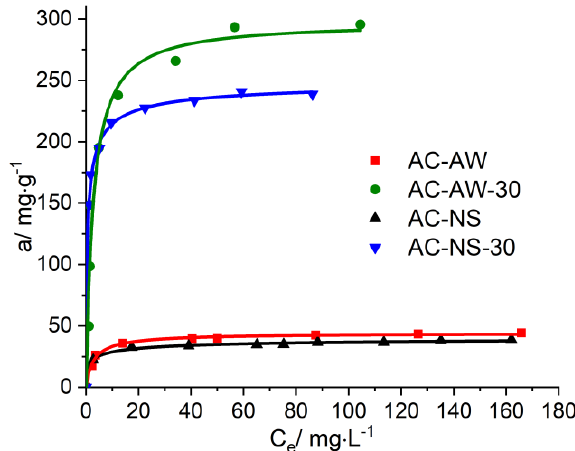
Figure 5. Adsorption isotherms of vitamin B 12 on AC-NS, AC-NS-30, AC-AW, AC-AW-30.